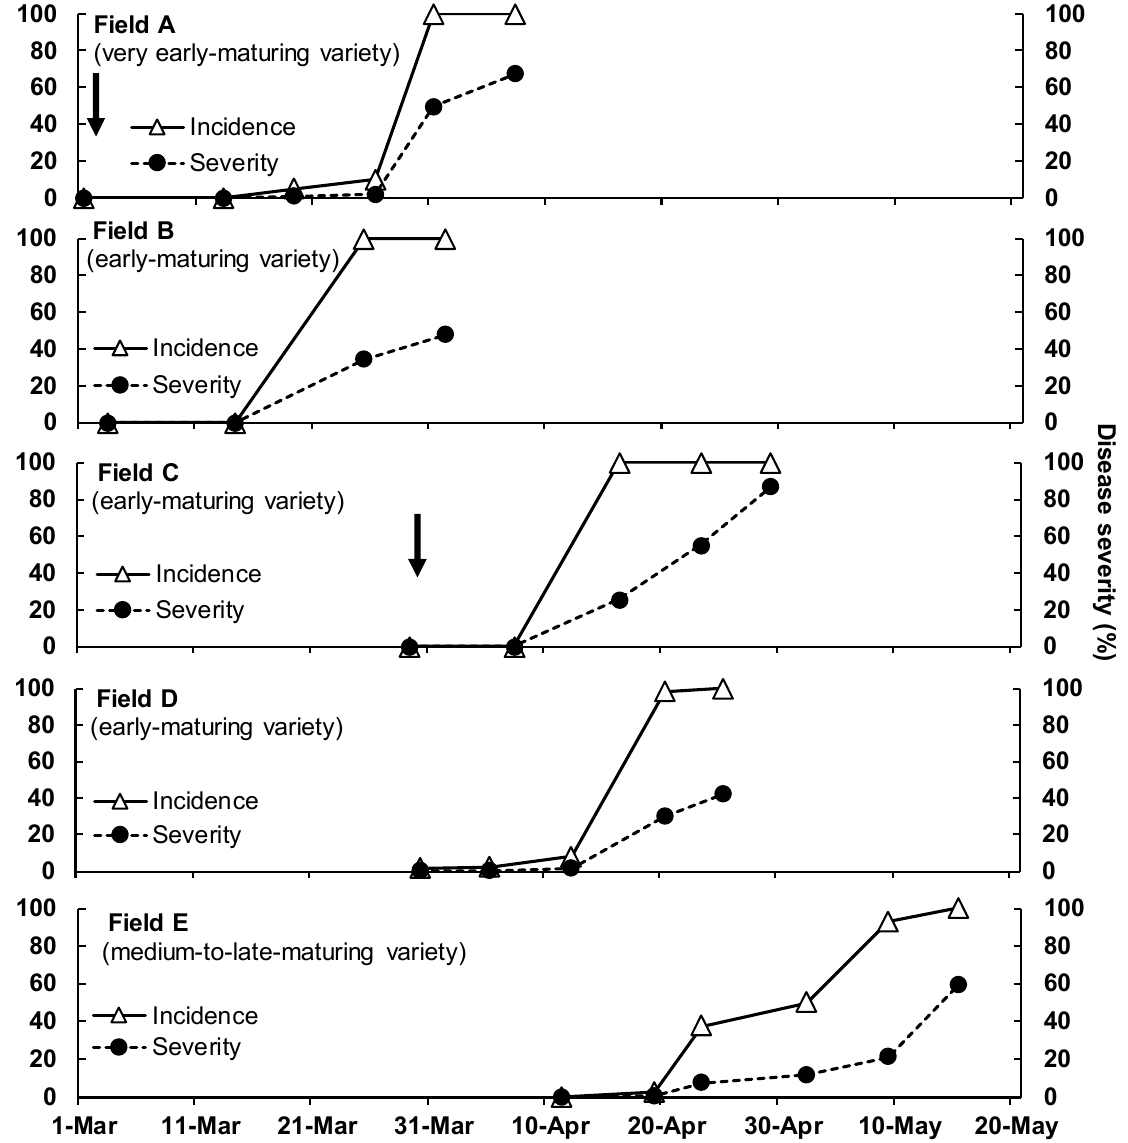
Figure 5. Development of onion downy mildew in unsprayed plots in 2016. Arrows indicate the field (day) in which infected plants were placed as an inoculum source.